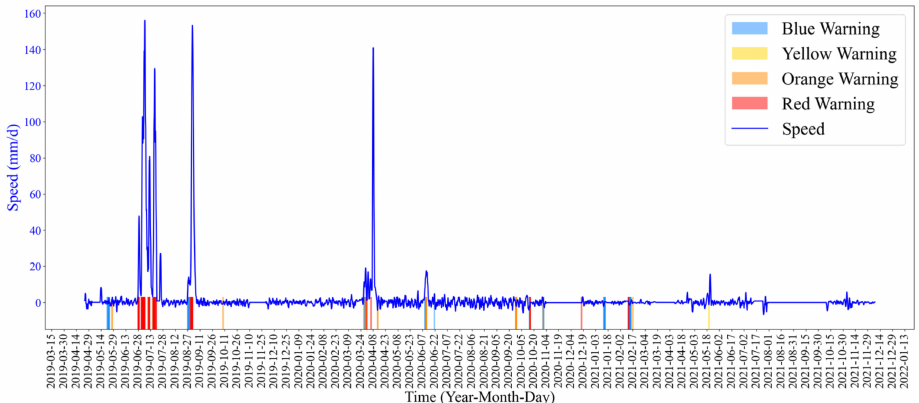
Figure 12. Threshold warning results of the Zhongma